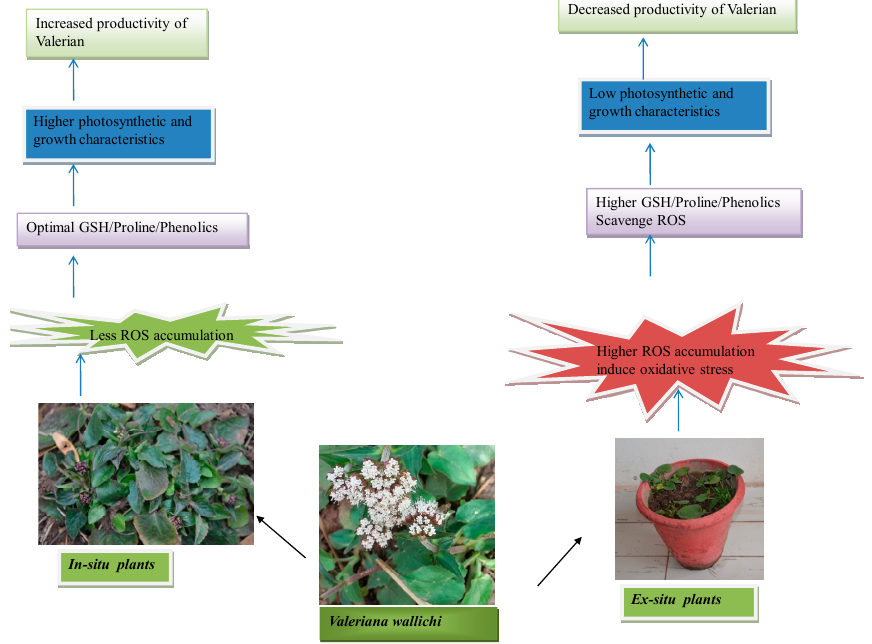
Figure 8. Mechanism of plant metabolism in in-situ and ex-situ grown Valeriana wallichii .